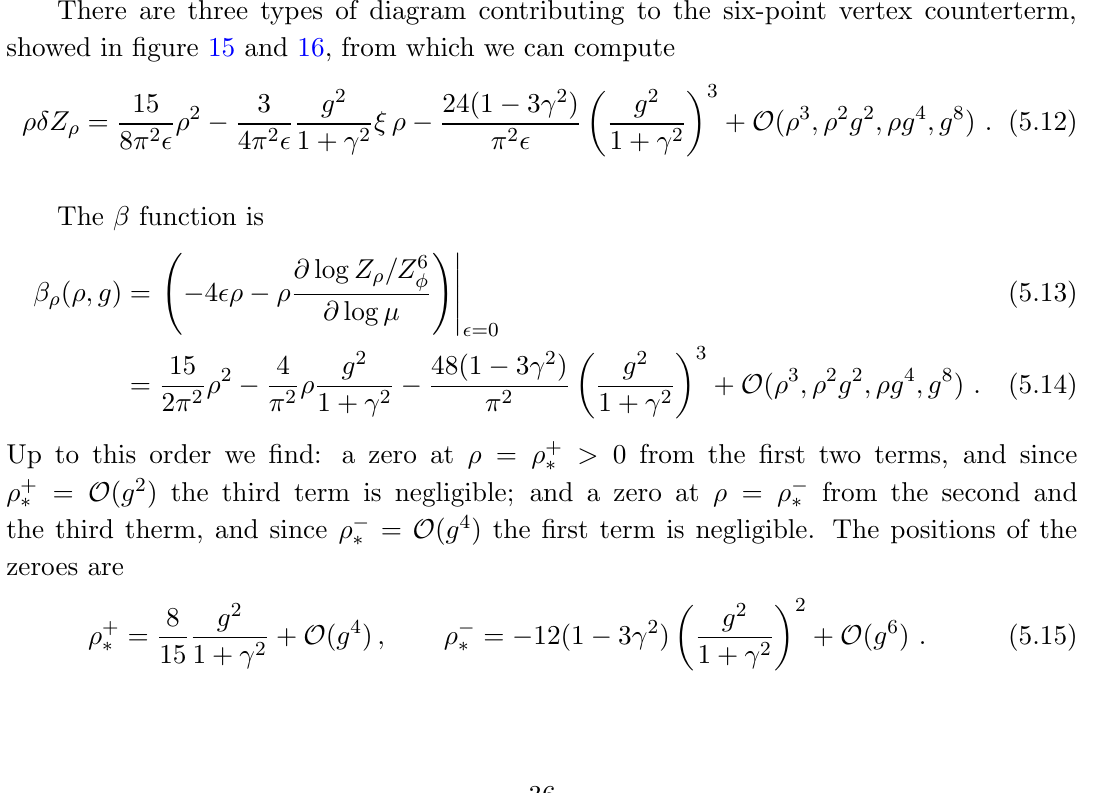
( (cid:26) 2 ) and ( (cid:26)g 2 ) in (cid:12) (cid:26) O O